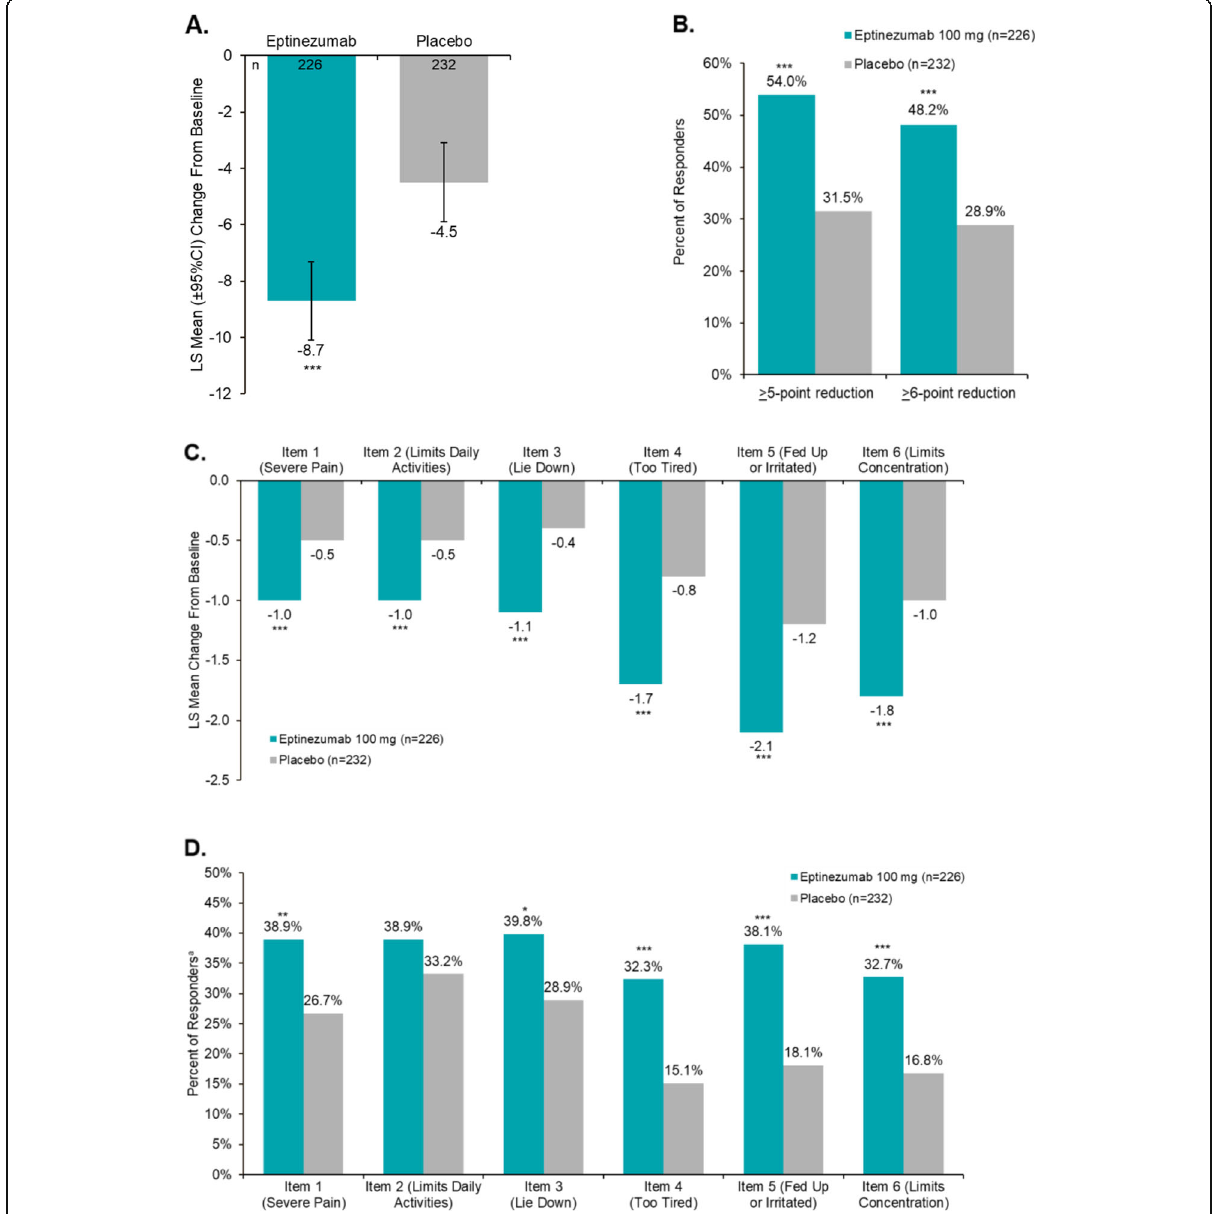
Fig. 1 Effects of Eptinezumab vs Placebo on HIT-6 – Related Outcomes. A Least Squares (LS) Mean Change From Baseline at Week 4; B Responder Rates at Week 4 for HIT-6 Total Score; C LS Mean Change From Baseline in HIT-6 Item Scores at Week 4; D Responder Rates for HIT-6 Item Scores at Week 4. CI, confidence interval; HIT-6, 6-item Headache Impact Test; LS, least square. * P < .05, ** P < .01, *** P < .001 vs placebo. Limited to patients with both baseline and post-baseline HIT-6 data. a For items 1 – 3, a responder was defined as a patient with an improvement of ≥ 1 category; for items 4 – 6, a responder was defined as a patient with an improvement of ≥ 2 categories [24]. Error bars represent 95%